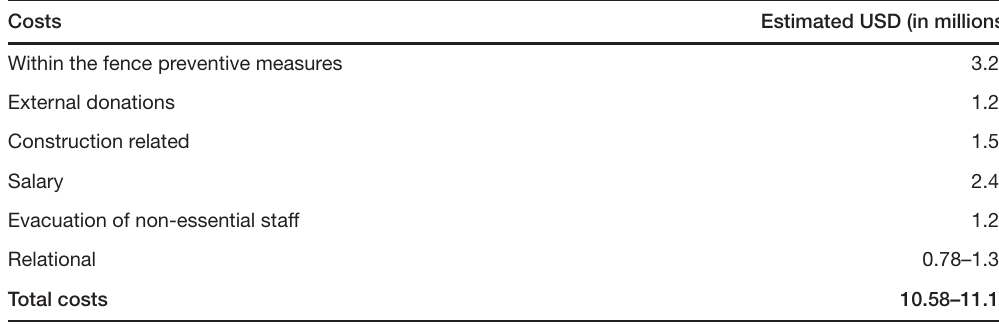
Table 2. Costs of preventive